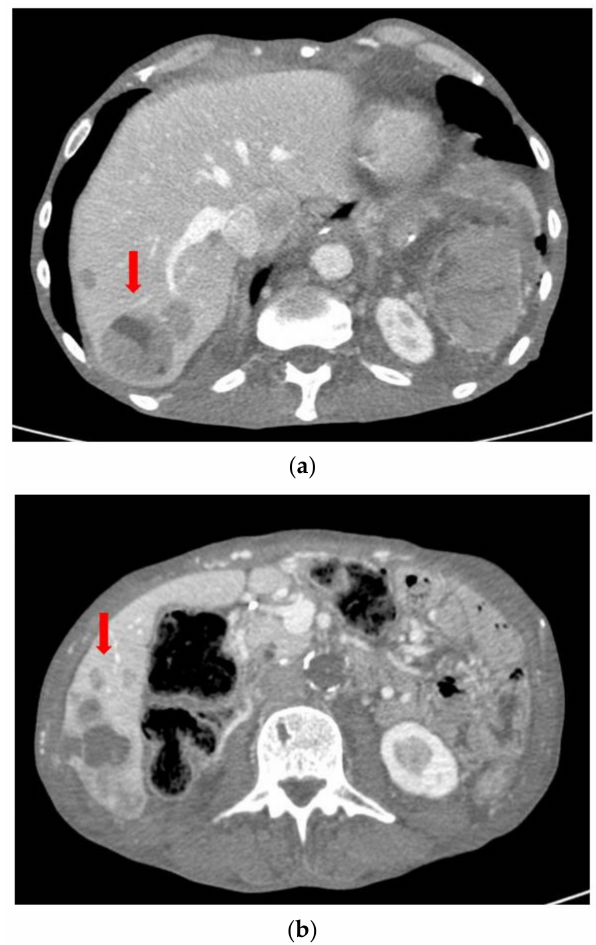
Figure 12. ( a ) Follow-up CT scan after 9 months with increased size and number of liver metastases in S7. ( b ) Follow-up CT scan after 9 months with increased size and number of liver metastases in S6.